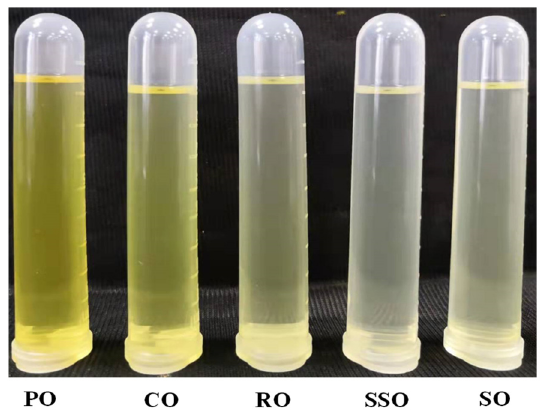
Figure 2. Appearance of the different vegetable oils before frying. PO, peanut oil; CO, corn oil; RO, rapeseed oil; SSO, sunflower seed oil; SO, soybean oil.